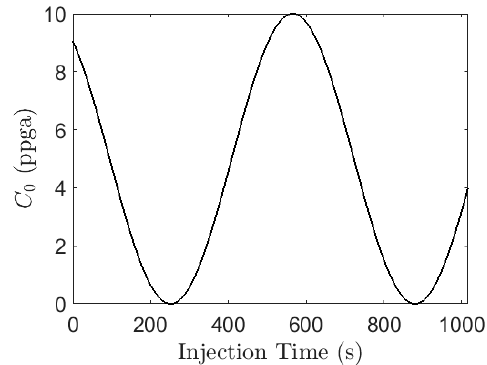
Figure 12. A sinusoidal input profile for injected proppant concentration.